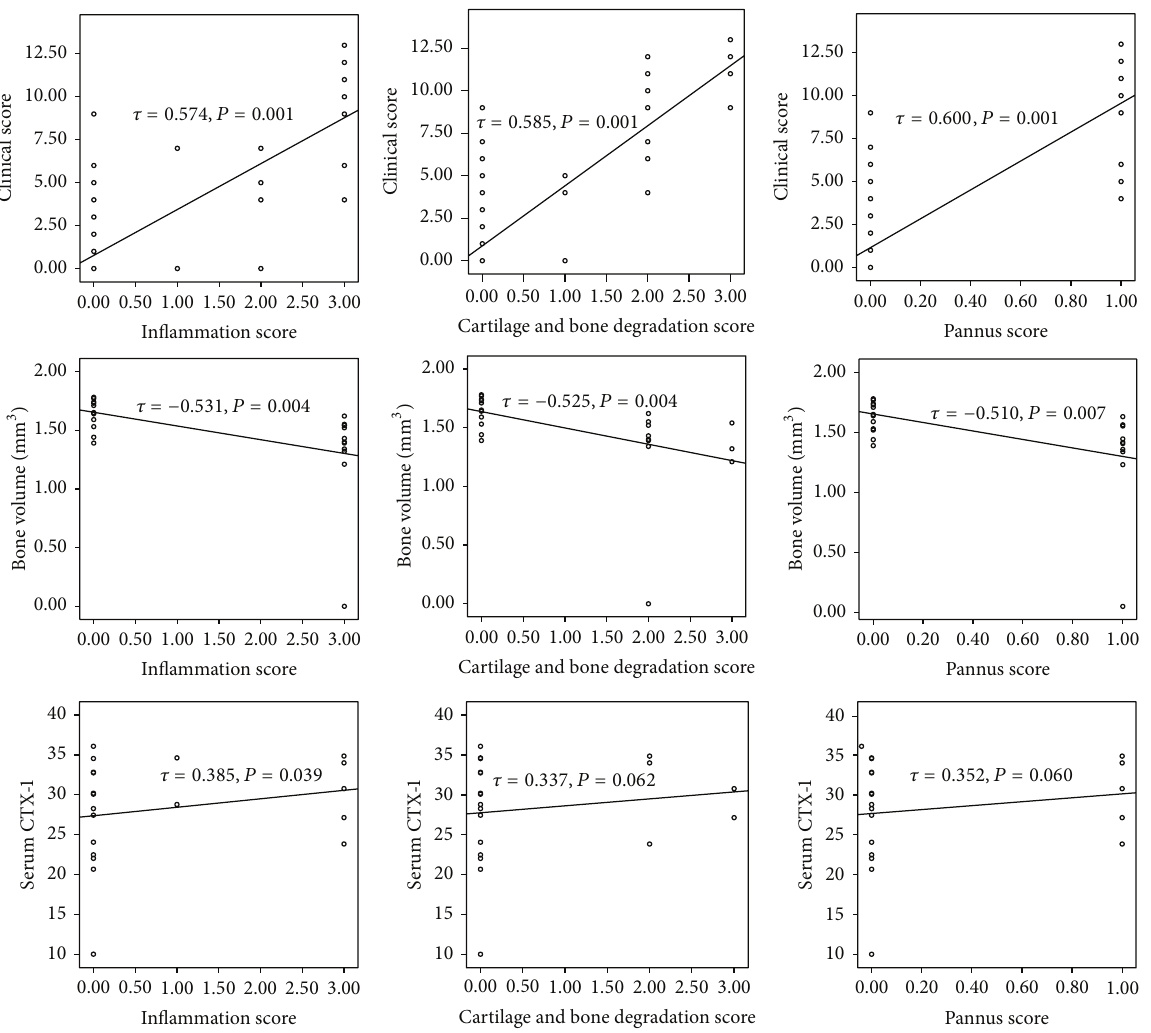
Figure 6: Bivariate correlations between clinical score, bone volume or serum CTX-1 ( 𝑦 -axis), and histological scores (inflammation score or cellular infiltration score, cartilage and bone degradation score, and pannus